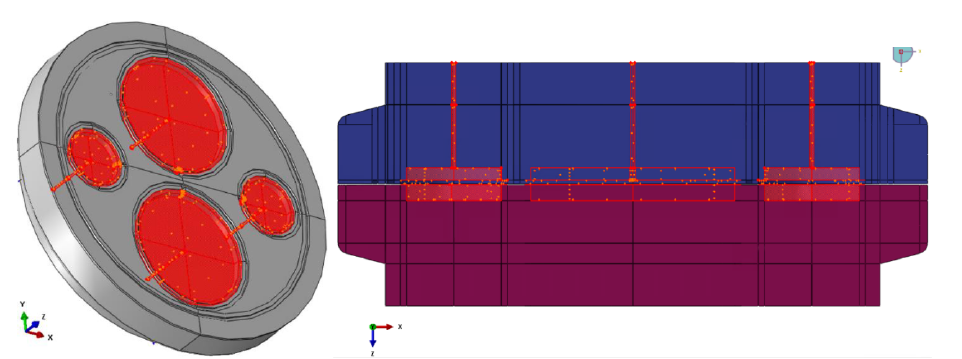
Figure 13. Pressure application in removable